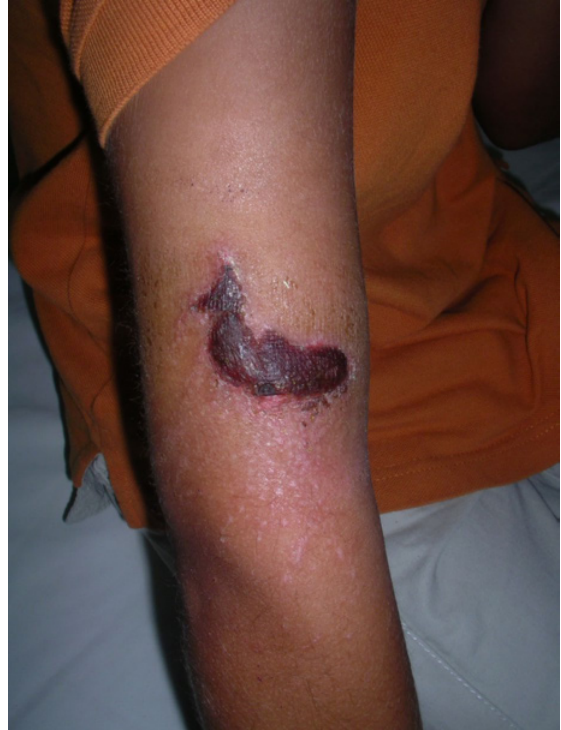
Figure 1. Bizarrely shaped allergic contact dermatitis after temporary henna tattoo on the upper arm.